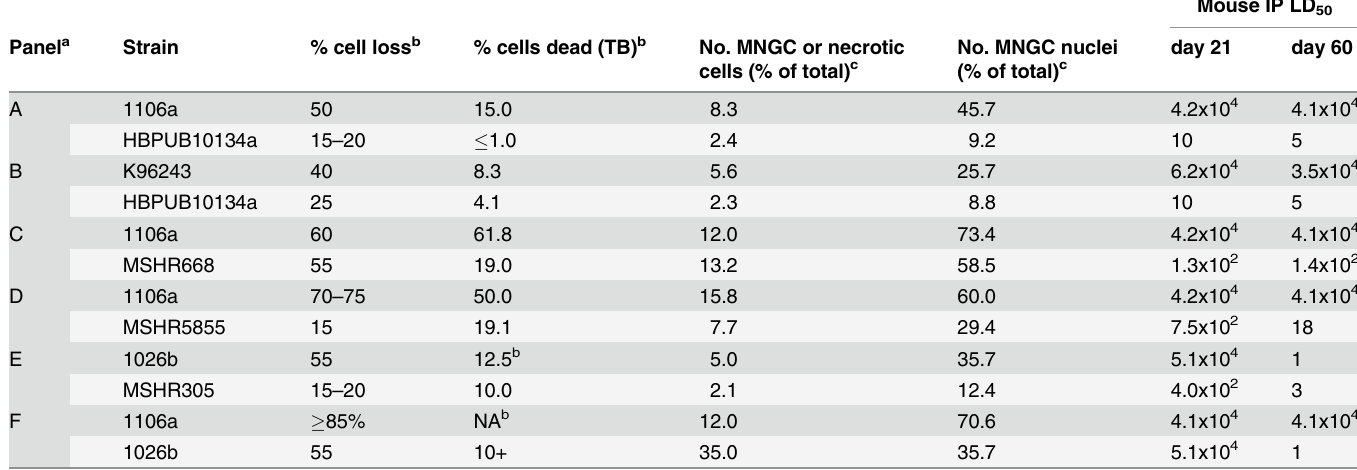
a Fig 6, panels A – F.